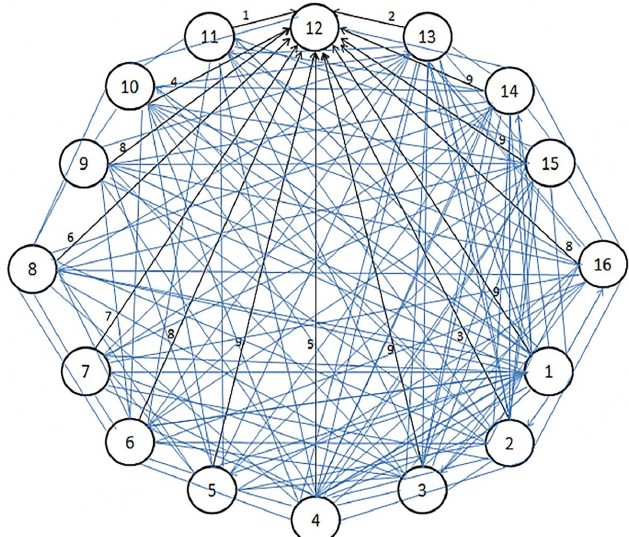
Fig. 3. The graphical relationships between criteria and strength of the impact to twelfth Source: compiled by authors.